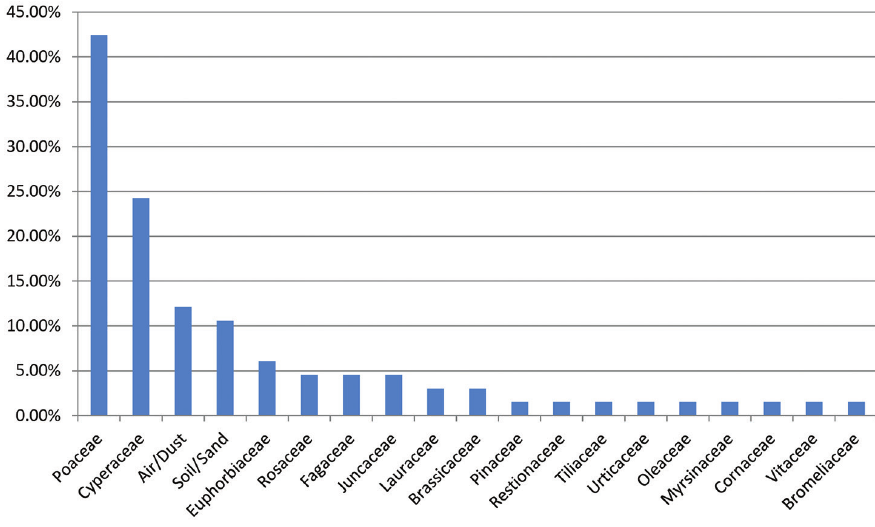
Figure 2. A Histogram to show fungus-host distribution of Arthrinium